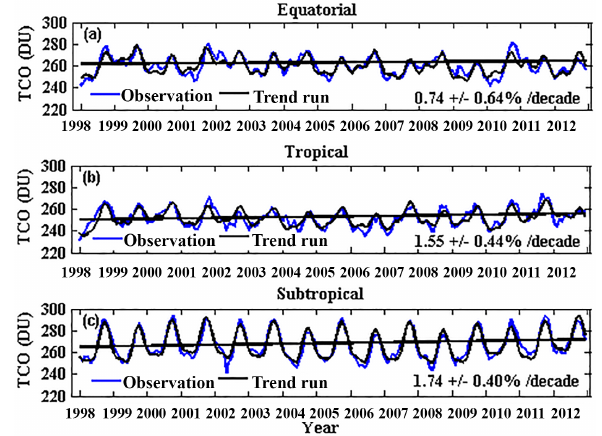
Figure 14. The same as Fig. 13 but per latitudinal region: equato- rial (a) , tropical (b) and subtropical (c)